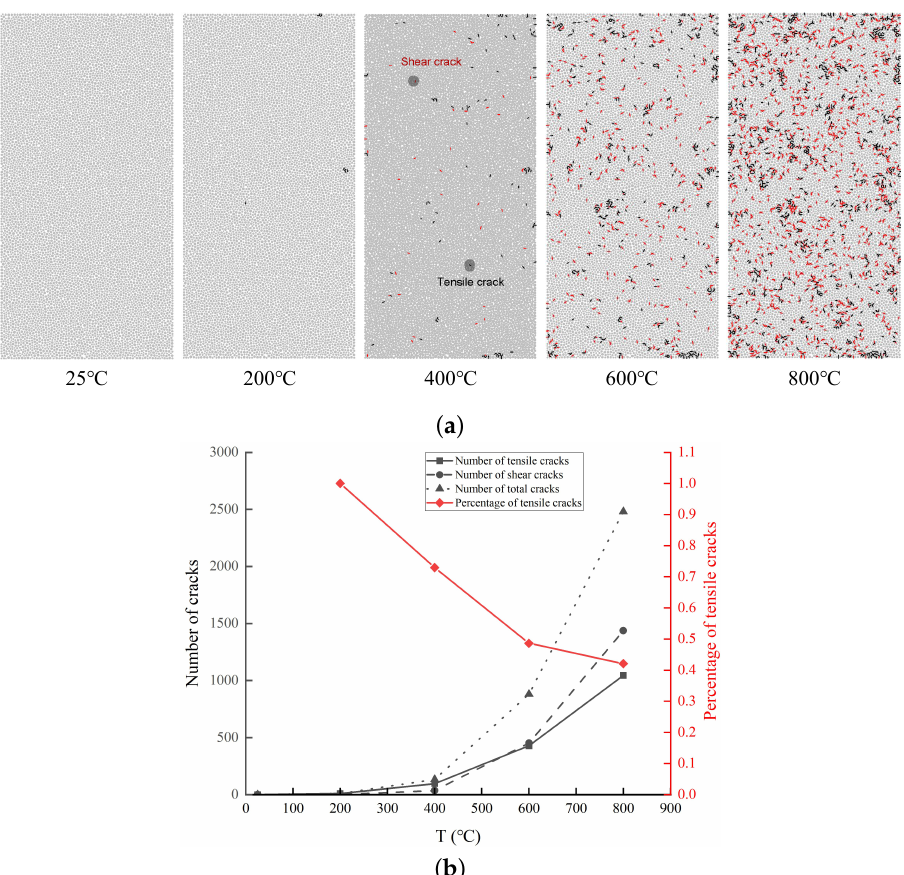
Figure 13. Thermal crack development. ( a ) Thermal crack distribution; ( b ) The number of